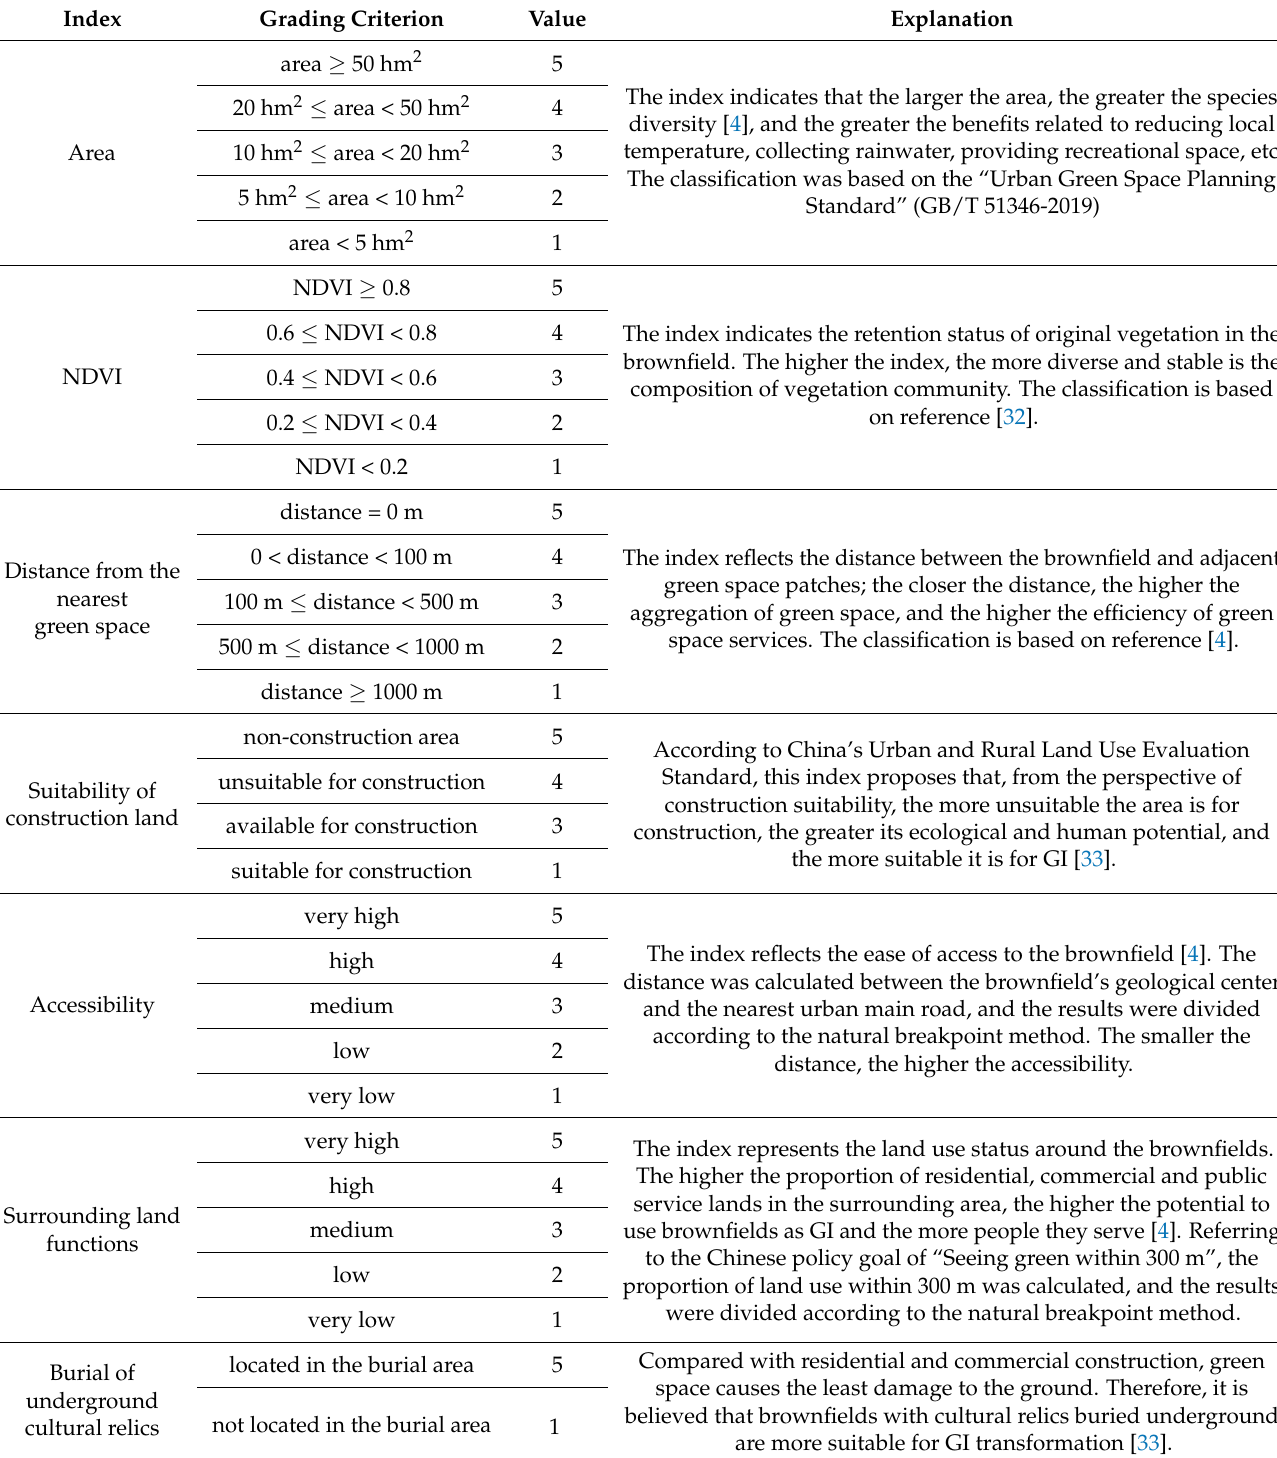
Table 2. Index grading criteria for the site suitability of brownfields catering for